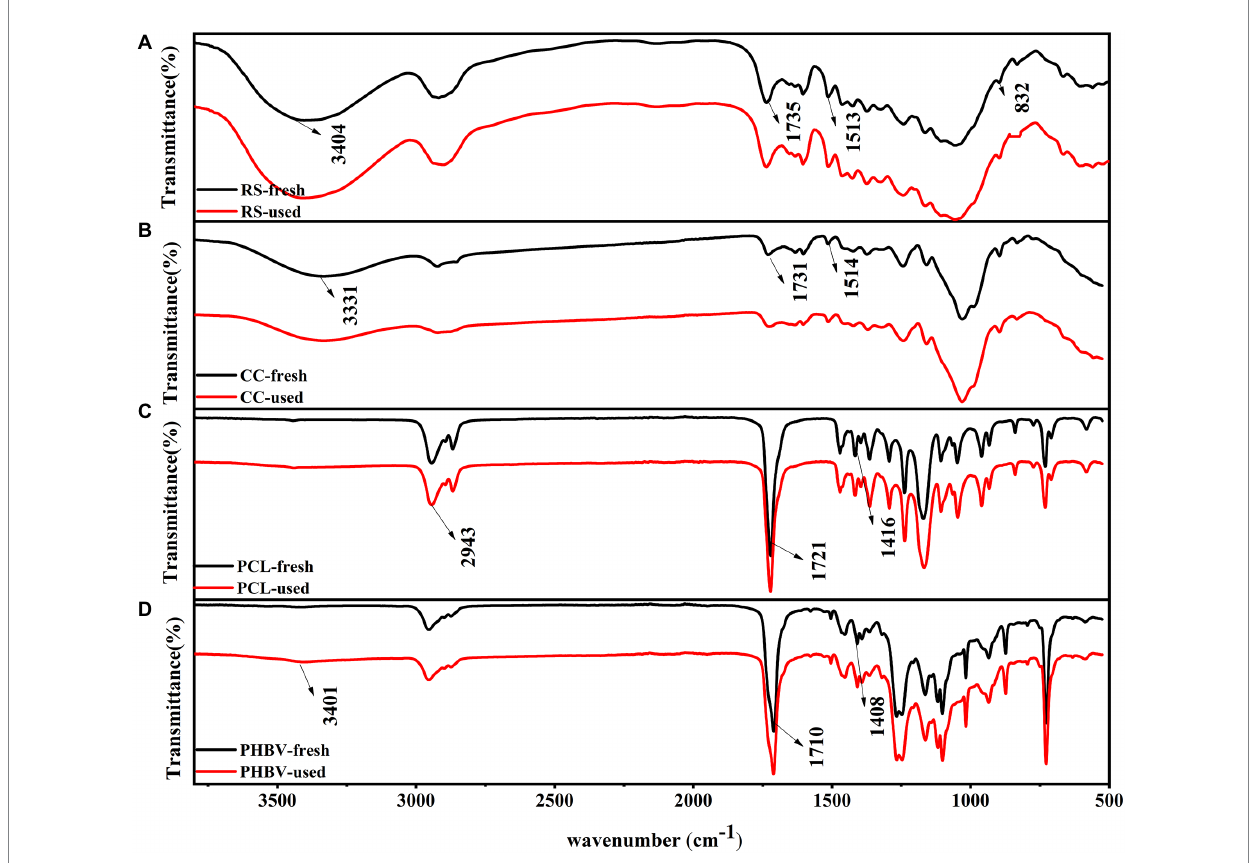
FIGURE 3 Comparison of FT-IR spectra of fresh and used carbon sources. (A) RS; (B) CC; (C) PCL; (D)